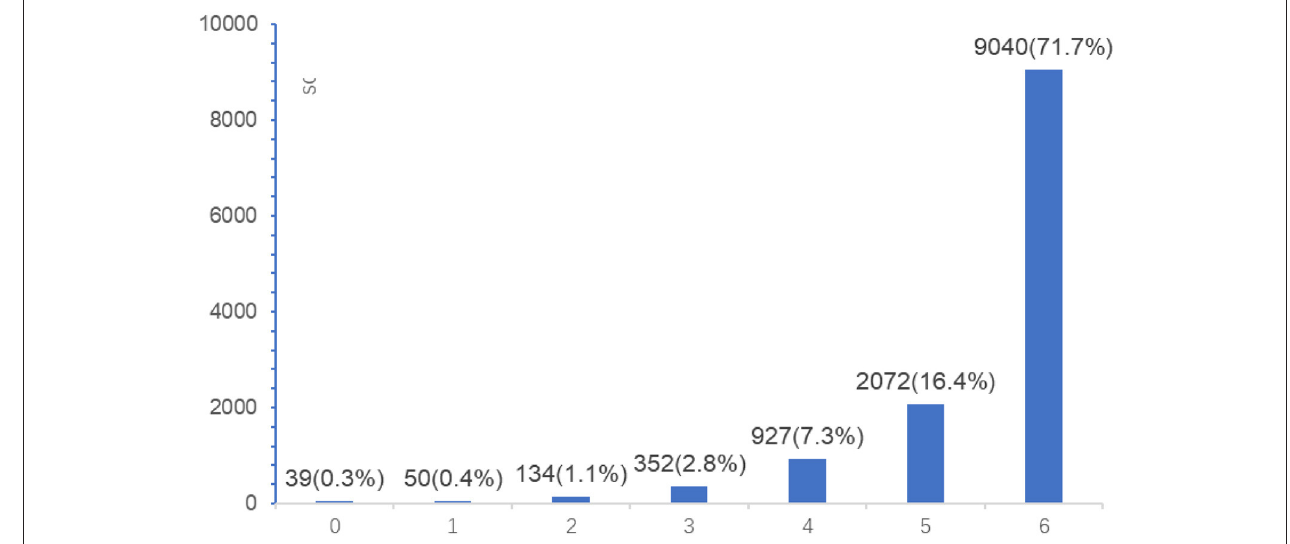
FIGURE 2 | Adherence to labor analgesia protocols among medical